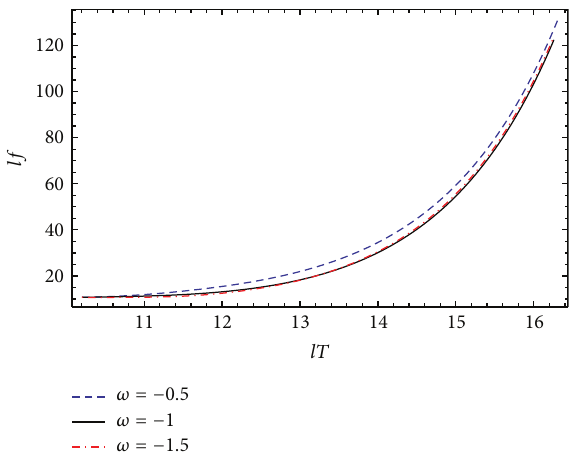
Figure 1: Evolution trajectories of reconstructed 𝑓(𝑇) for quintes- sence model in 𝑙𝑓 − 𝑙𝑇 planes with Ω 𝑚0 = 0.315 , 𝐻 0 = 67.3 , and 0 ⩽ 𝑧 ⩽ 10